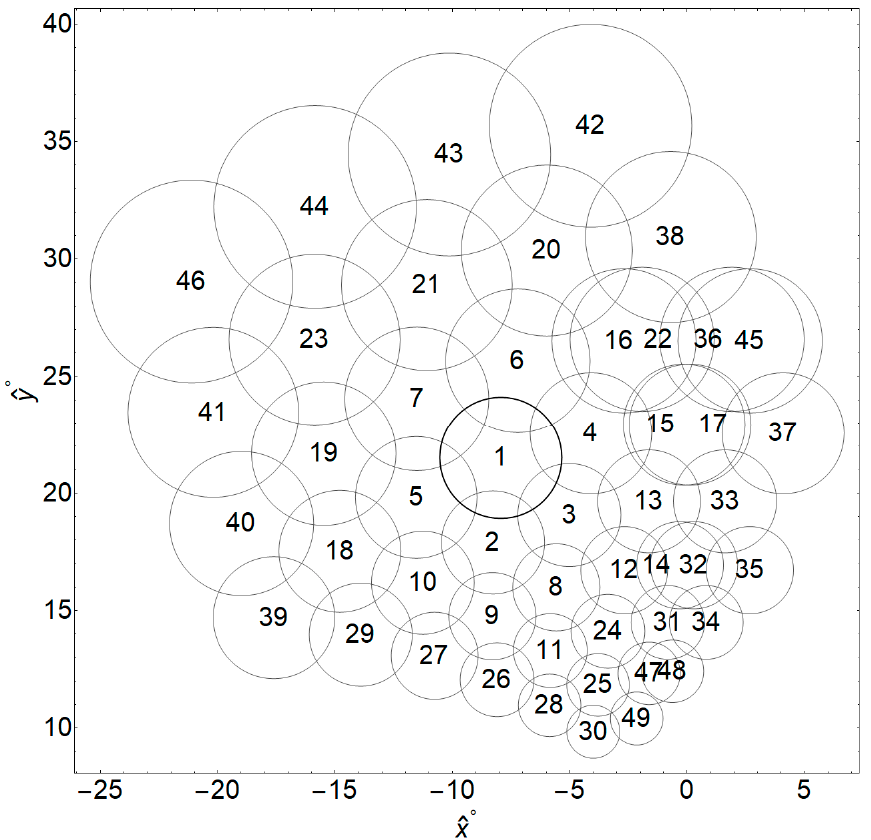
Figure 2. Visual regions corresponding to columns containing neurons that are used in computer simulations are shown using a numbering convention that is described in Section 2.2. Small-scale simulations of a network consisting of neurons in columns corresponding to regions 1–25 are reported in [35,36] and are replicated here. Additional research reported in the present paper is based on simulations of neurons in columns corresponding to all 49 regions that are depicted